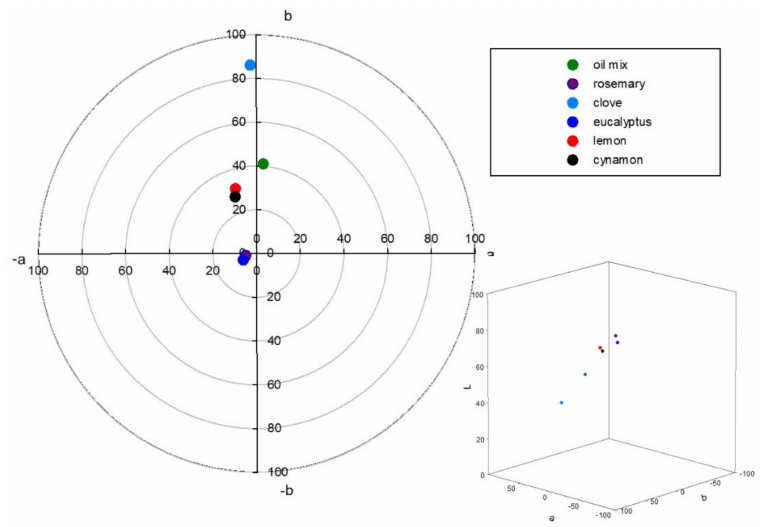
Figure 5. L * a * b * color space diagram of the